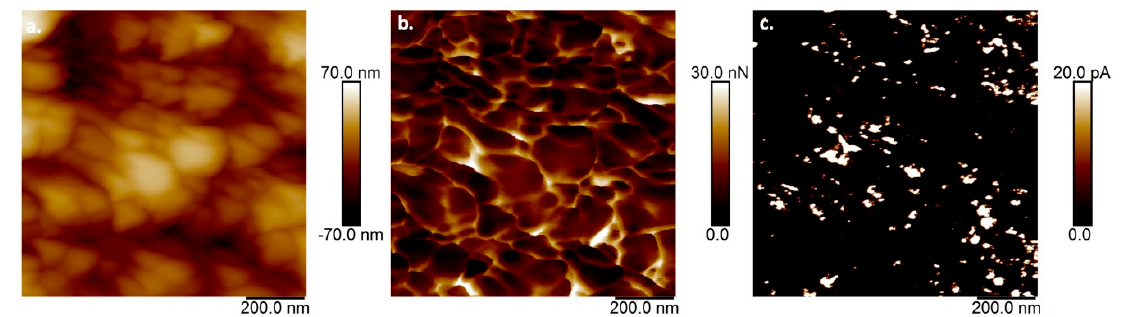
Figure 3. Atomic force microscopy images of SDS/poly (3,4-ethylenedioxythiophene) (PEDOT)/AuNP/MWCNT coating, ( a ) topography, ( b ) adhesion, and ( c ) tunneling-atomic force microscopy (TUNA) electrical conductivity.